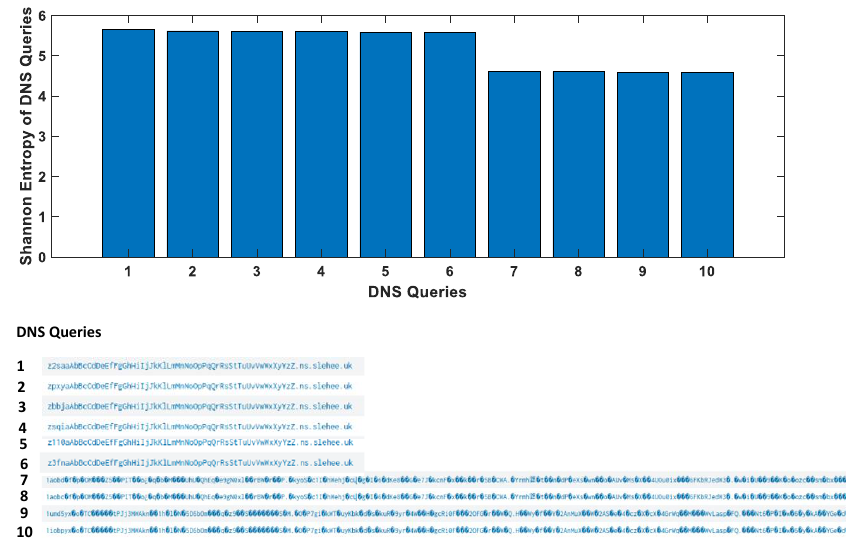
Figure 8. The first part of the figure shows Shannon entropy score of DNS queries. The second part of the figure lists the DNS